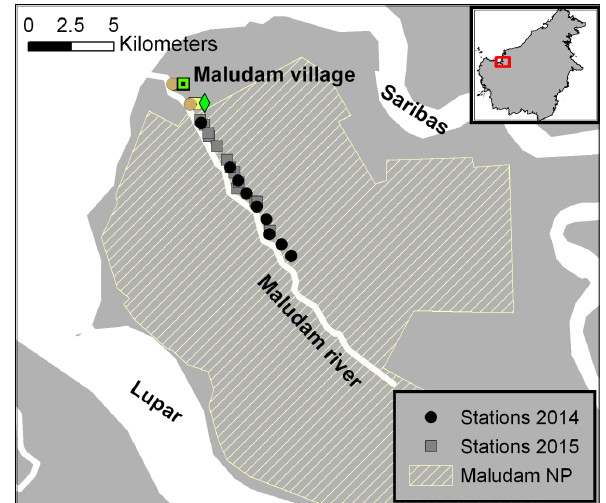
Figure 1. Map showing the location of the Maludam national park between the rivers Lupar and Saribas. The black and grey symbols denote sampling locations, the green diamond shows the location of a waste water treatment plant, and the green square indicates the location of Maludam village. The yellow markers refer to sampling stations outside the national